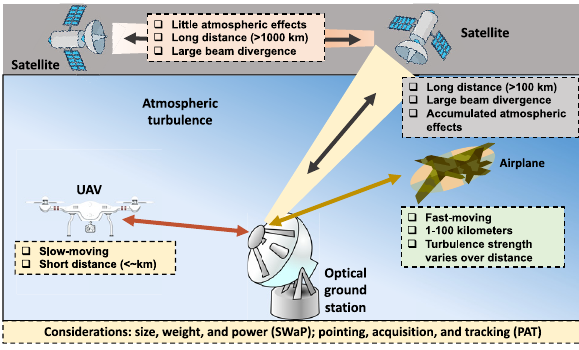
Figure 5: Orbital-angular-momentum (OAM) – multiplexed free- space optical airborne and satellite communications.